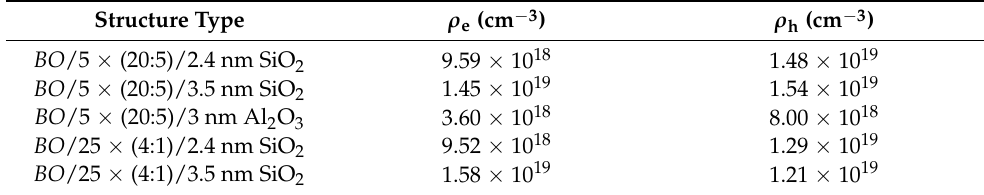
Table 1. Spatial density of trapped electrons, ρ e , and holes, ρ h , for the structures annealed in O 2